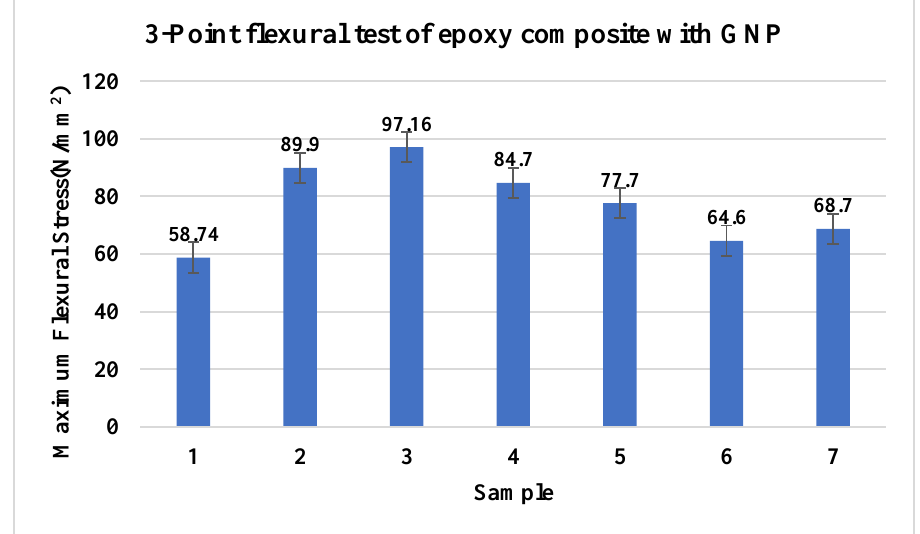
Materials 2022 , 15 , x FOR PEER REVIEW Figure 3. Maximum flexural stress of 3-point bending test. Figure 3. Maximum flexural stress of 3-point bending test.